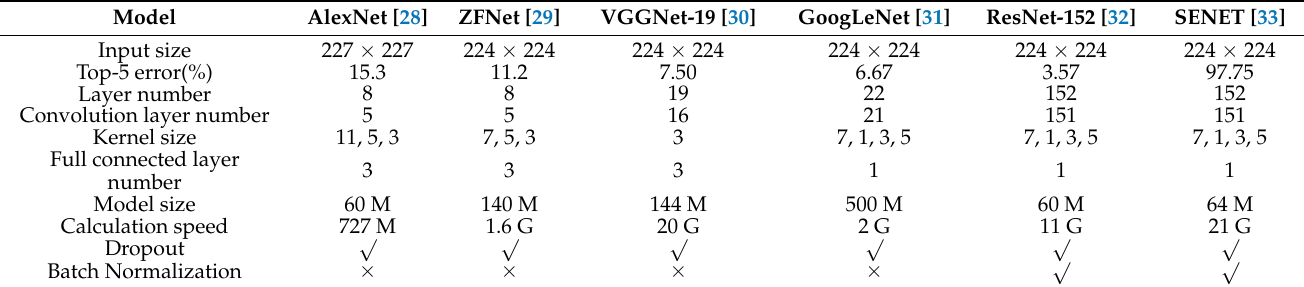
Figure 2. The general architecture of a convolutional neural network. Table 1. Comparison of convolution neural networks for computer vision.